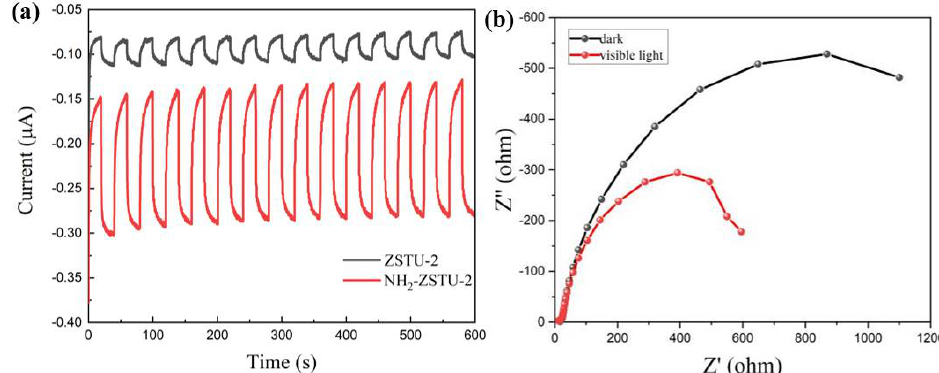
Figure 6. Photoelectrochemical characterizations of photocatalysts. Transient photocurrent plots of NH 2 -ZSTU-2 and ZSTU-2 ( a ); EIS curves of NH 2 -ZSTU-2 under dark and visible light ( b ).